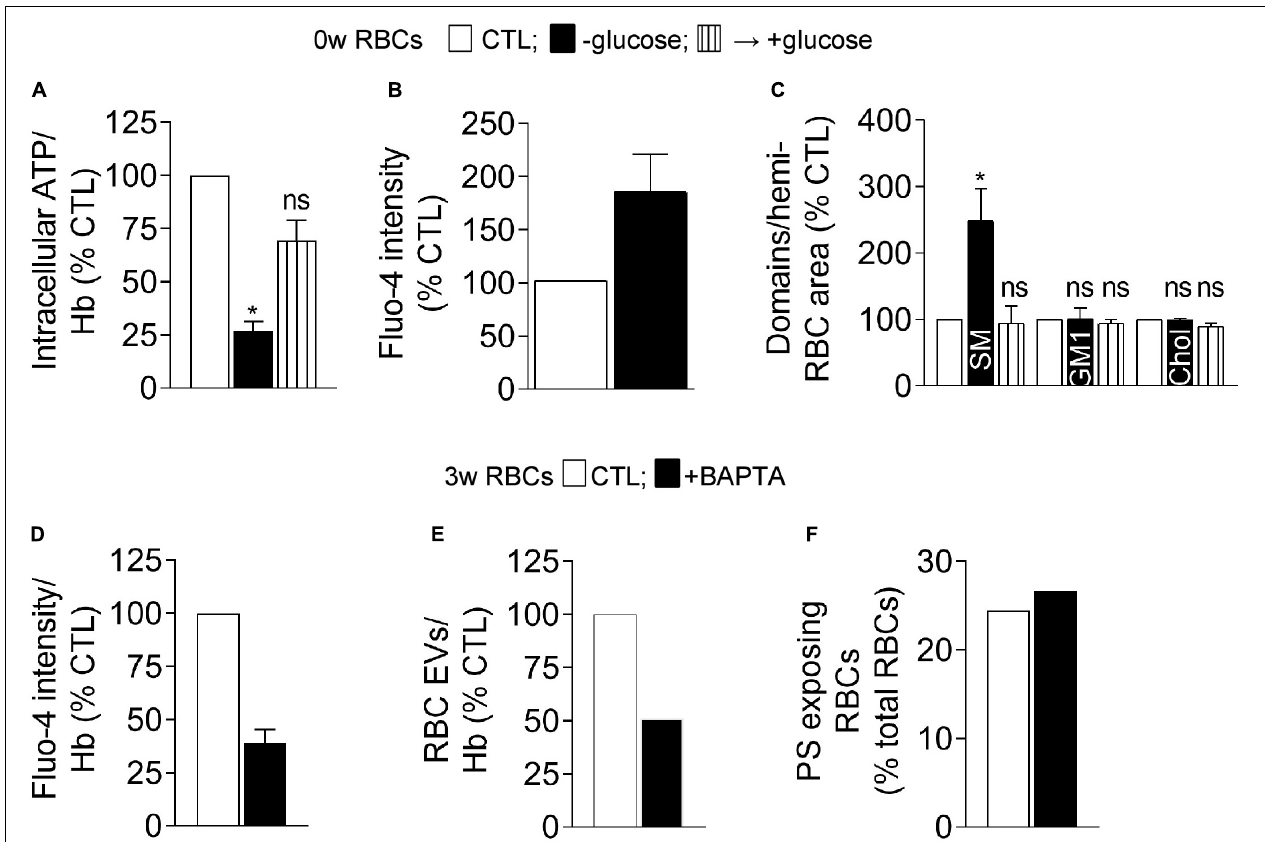
FIGURE 8 | Acute ATP depletion in fresh RBCs increases the calcium content and the abundance of sphingomyelin-enriched domains whereas calcium chelation in 3 week-stored RBCs decreases the extent of vesiculation but not PS externalization. (A–C) Isolated fresh RBCs were incubated or not (open columns) in a medium devoid of glucose for 2 h to induce acute ATP depletion, followed or not (-glucose, black columns) by reincubation in a glucose-rich medium for 1 h for ATP repletion ( + glucose, stripped black columns). RBCs were then analyzed for ATP content (A) , calcium content (B) , and abundance of lipid domains (C) . (A) RBC ATP content determined as in Figure 1E . Data were expressed in % of the CTL condition and are means ± SEM of 3 independent experiments (Friedman test followed by Dunn’s multiple comparisons test). (B) RBC calcium content. RBCs were labeled with Fluo-4-AM as in Figure 3A , immobilized on a silicon chamber and observed by fluorescence microscopy under destretching of the chamber for 7 min. Data were expressed in % of the CTL condition and are means ± SD of triplicates from 1 representative experiment out of two. (C) RBC lipid domain abundance counted as in Figure 5 . Means ± SEM of 4–6 experiments (Wilcoxon signed rank test). (D–F) RBCs stored for 3 weeks at 4 ◦ C were isolated, incubated or not (CTL, open columns) with the intracellular calcium chelator BAPTA-AM (black columns) and analyzed for their calcium content (D) , EV production (E) , and PS surface exposure (F) . (D) RBC calcium content determined with Fluo-4-AM as in Figure 3A . Data were expressed in % of the CTL condition and are means ± SD from 2 independent experiments. (E) Abundance of EVs produced by RBCs. After incubation or not with BAPTA-AM, RBCs were pelleted to collect EV-containing supernatants which were submitted to ultracentrifugation to isolate EVs. EV abundance was then determined by Nanoparticle tracking analysis and normalized to the Hb content (as an estimation of the RBC abundance). Data were expressed in % of the CTL condition. (F) Proportion of PS-exposing RBCs determined as in Figure 4G . Data were expressed in % of total RBCs. ns, not significant; * p <